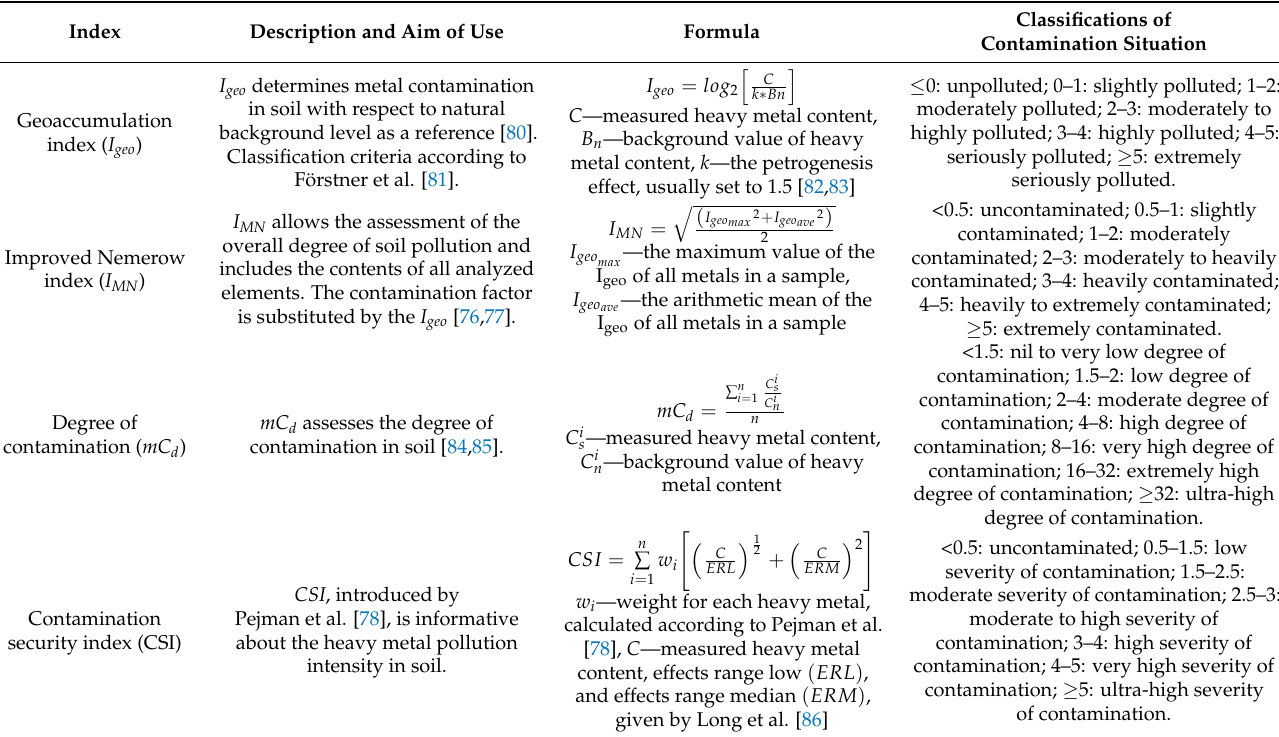
Table 1. Indices of pollution used in this study.